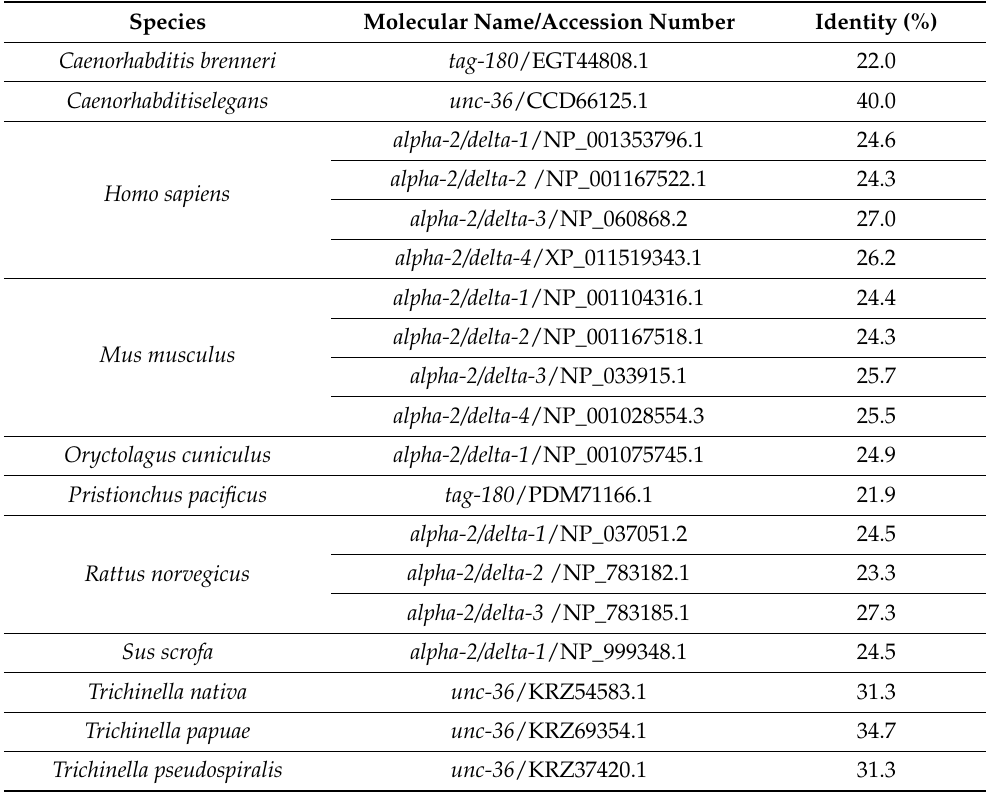
Table 2. DdCa v α 2 δ information used for sequence alignment and phylogenetic